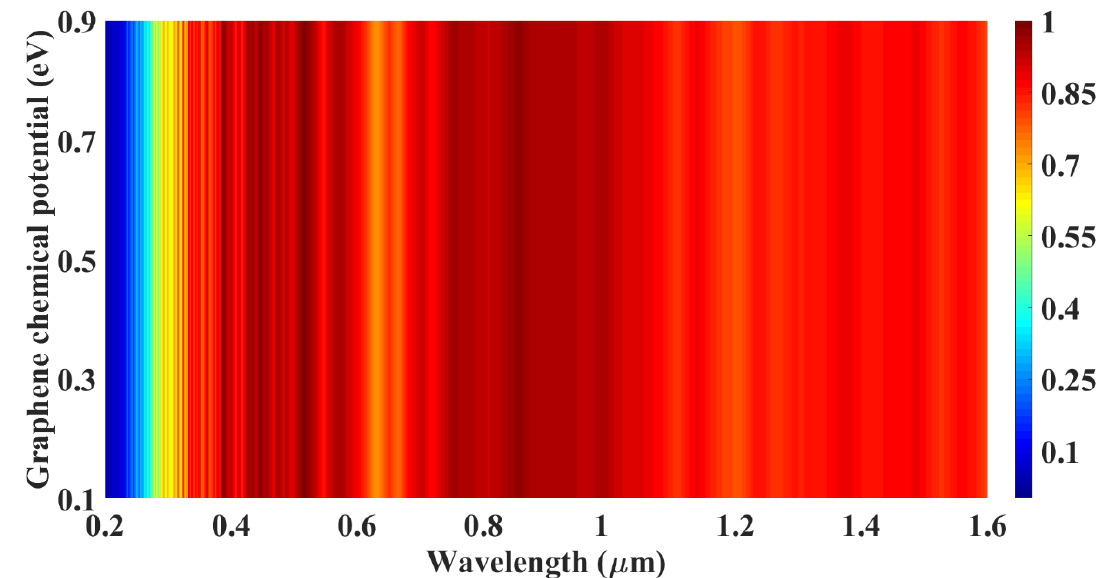
Figure 5. The graphene’s potential variation results. The wavelength spectrum of 0.2 micrometer to 1.6 micrometer. The chemical potential of graphene is changed between 0.1 and 0.9 eV. For varied graphene chemical potentials, the absorption remains unchanged.